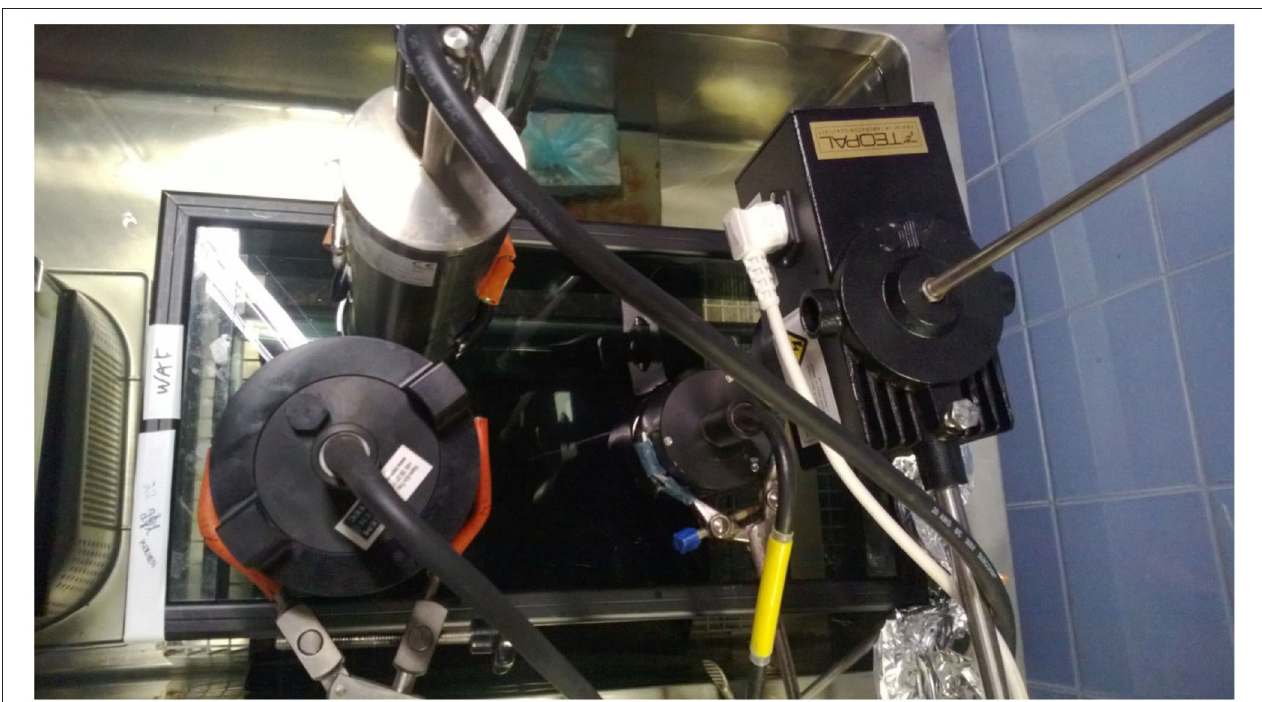
FIGURE 1 | Above view of the experimental set up. Instruments: TriOS EnviroFlu-HC (with metallic cover, upper part), Turner C3 (with black cover, left) and UviLux (black cover, right). The electric motor of the stirrer is at far right. Photograph: Harri Kankaanpää.